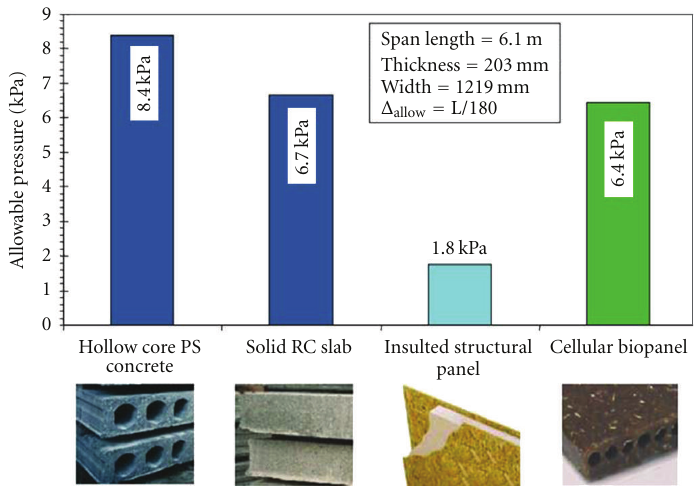
Figure 16: Performance of cellular biocomposite panels against conventional slab and panel systems for commercial and residential cons- truction [186].